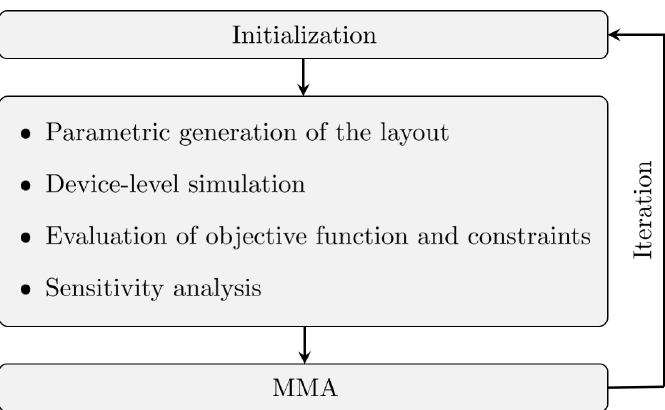
Figure 1. Workflow of feMEMSlite